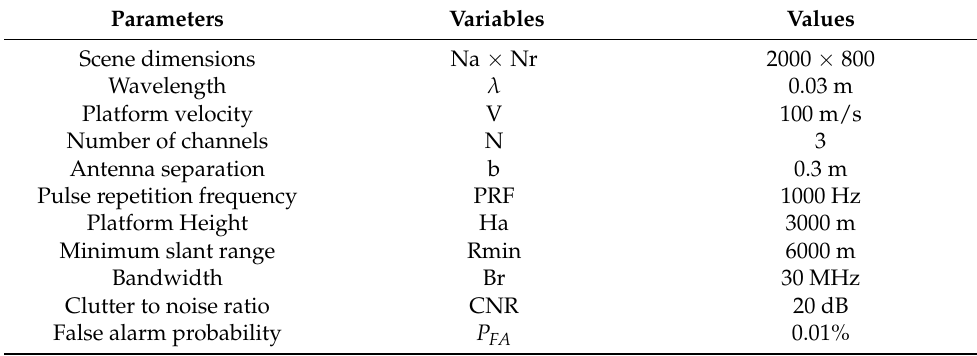
Table 1. System and geometry